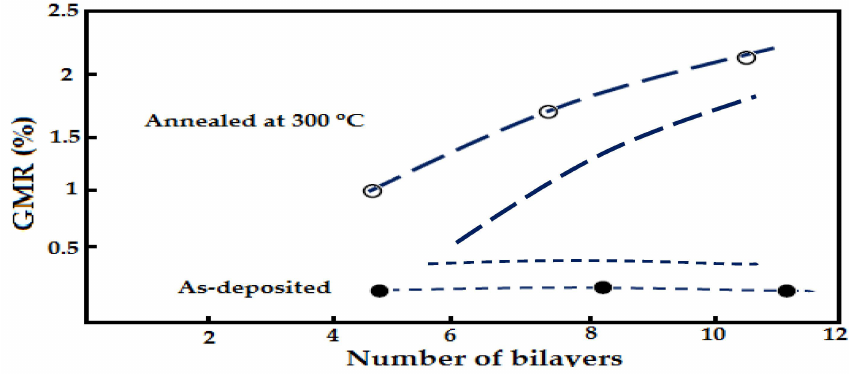
Figure 17. Annealed GMR multilayer in flowing argon by Siritaratiwat et al.